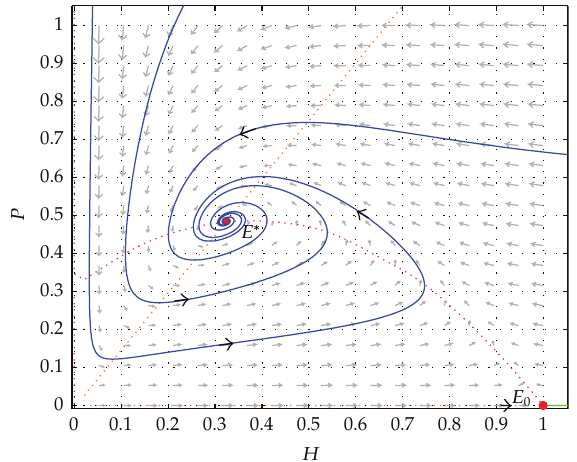
Figure 6: The phase portrait of model (7) with the weak Allee effect. The parameters are taken as 𝑎 = 0.8 , 𝛿 = 1.5 , 𝑚 = 0.75 , and 𝑟 = 0.025 . The positive equilibrium 𝐸 ∗ = (0.3232928050, 0.4849392075) is an unstable focus surrounded by a stable limit